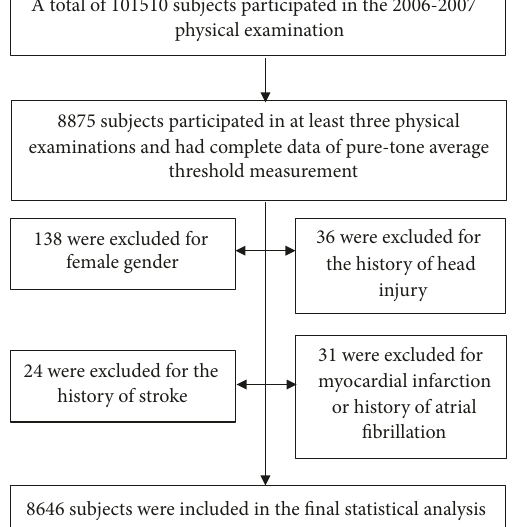
Figure 1: A flow chart of the current